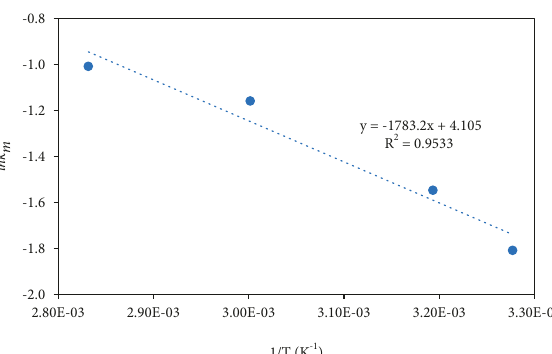
Figure 3: Dependence on temperature for the extraction of lipids from municipal sewage sludge (MSS) with scCO